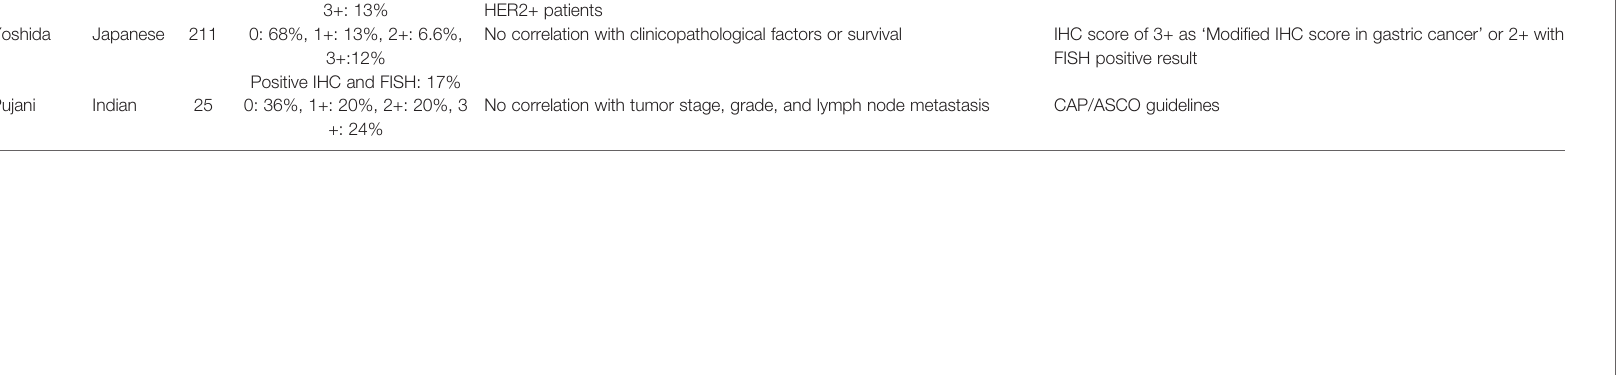
TABLE 5 | Summary of previous studies on microsatellite instability in gallbladder